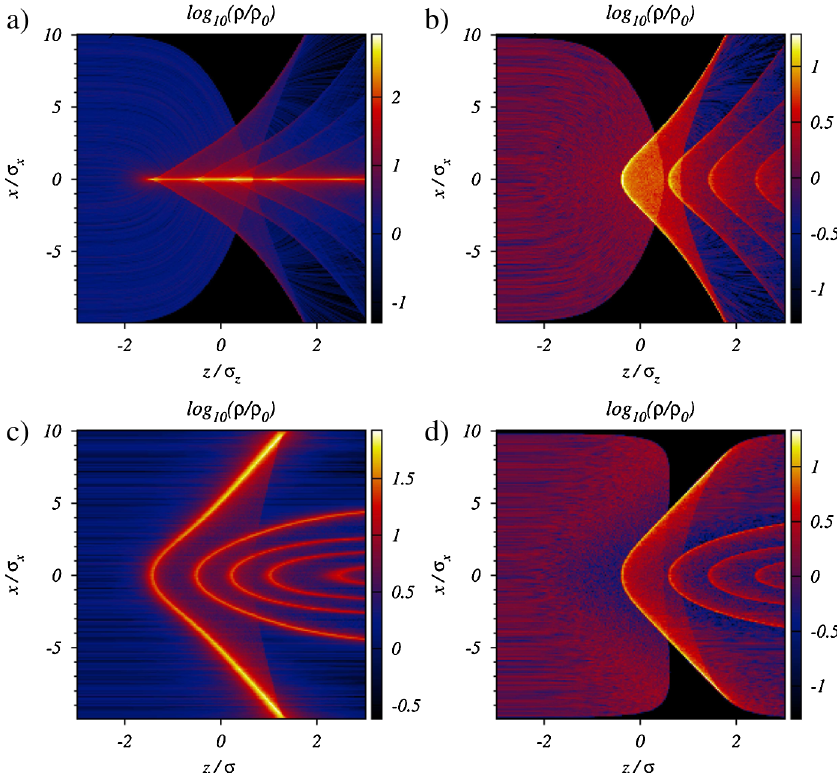
FIG. 1. (Color) Electron density enhancement in the x (cid:2) z plane at y ¼ 0 (left) and y ¼ 2 (cid:2) r (right) in a field-free region (top) and in a dipole (bottom), for a Gaussian